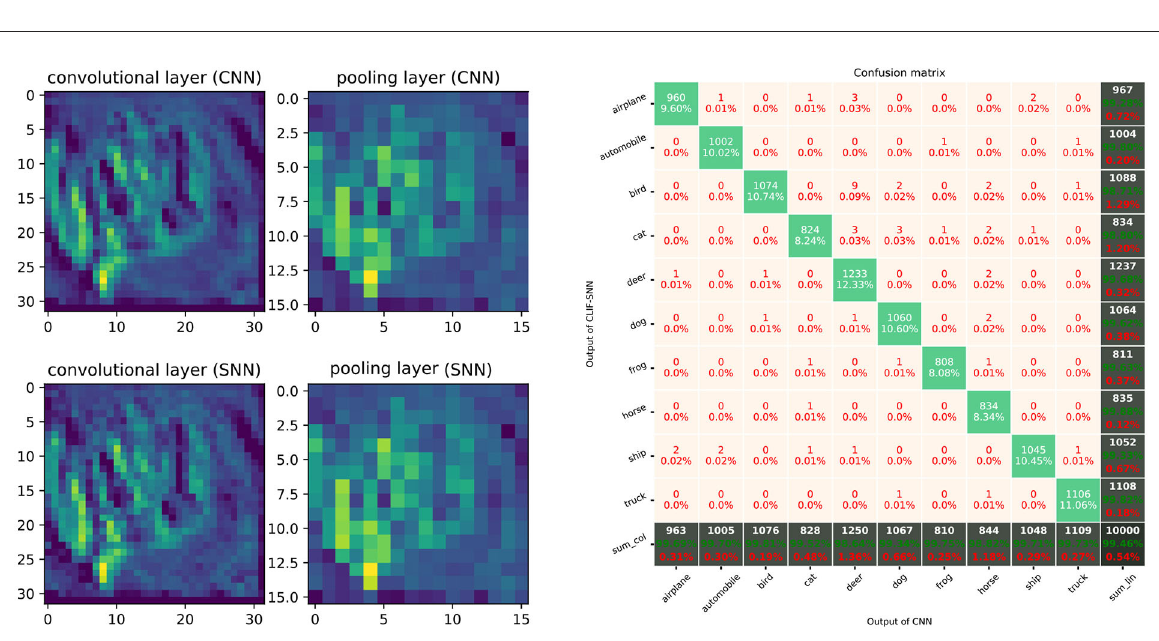
FIGURE17 Performance of SNN with AlexNet architecture. The left part of figure shows the comparison of feature maps of convolutional layers and max-pooling layer between ReLU-based CNN and LIF-SNN with same input and connection weights. The right part of figure shows the confusion matrix for CIFAR-10